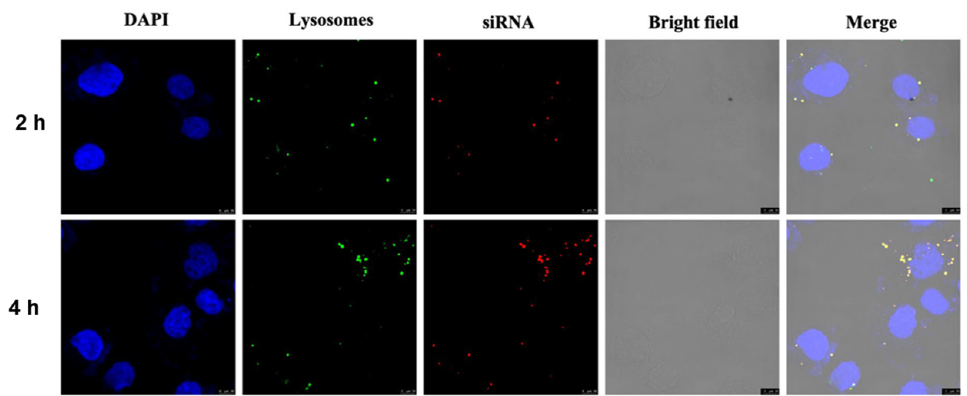
Figure 7. Intracellular uptake images of TFSPEI polyplex in CT26 incubated for 2 h and 4 h. Bars = 10 μ m. (blue: DAPI; green: LysoTracker Green; red: Cy5-labeled siRNA). Bars = 10 µ m. (blue: DAPI; green: LysoTracker Green; red: Cy5-labeled